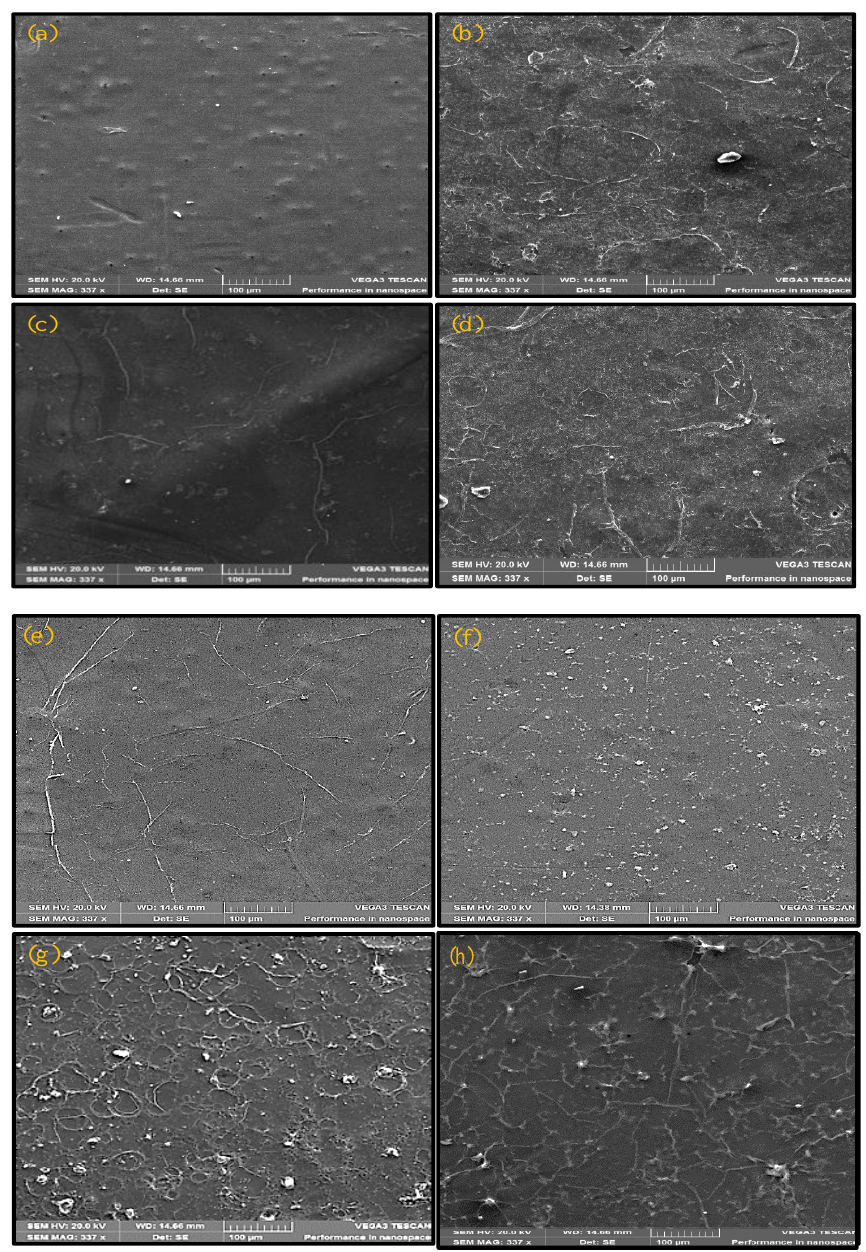
Figure 9. SEM surface morphology of ( a ) M0, ( b ) M1, ( c ) M2, ( d ) M3, ( e ) M4, ( f ) M5, ( g ) M6 and ( h ) M7.